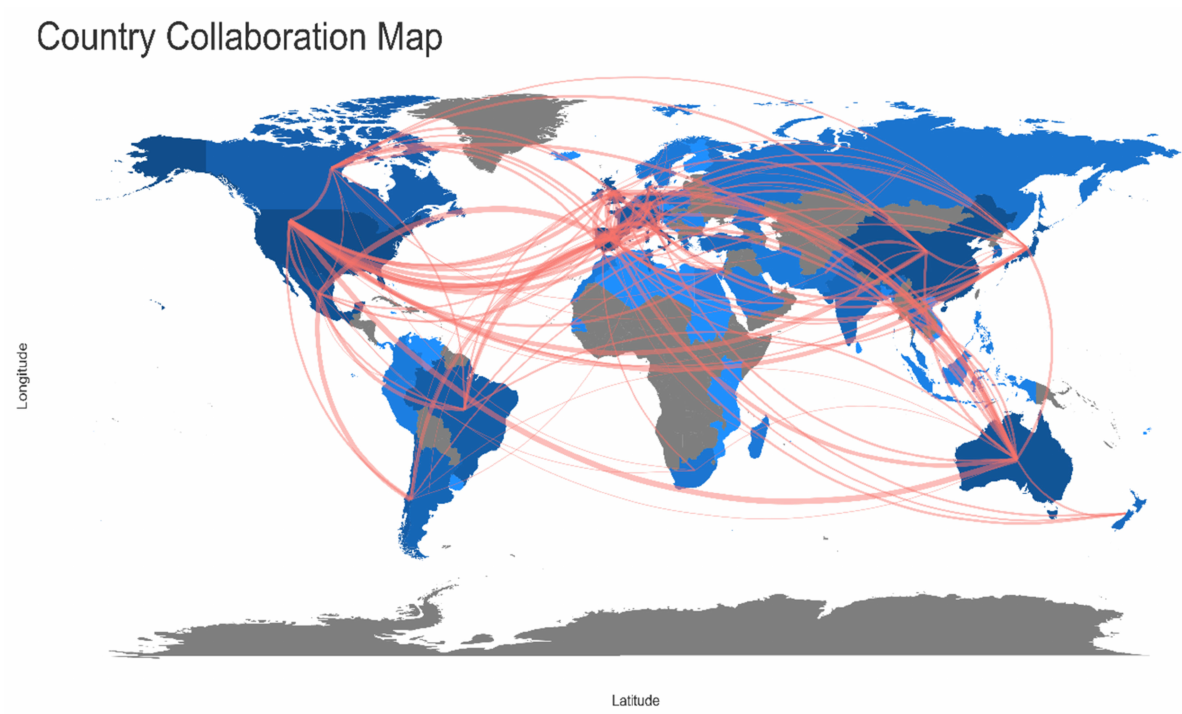
Figure 5. World map showing research collaborations among countries from 2011 to 2020 (“recent period”). Brighter blue color indicates a higher collaboration rate. Connectors do not show countries with less than three shared papers. Table 6. Information about the countries (first ten positions) with the higher frequency of collabora- tion from 1985 to 2010 (“earlier period”: EP) and from 2011 to 2020 (“recent period”: RP). The first three items are in